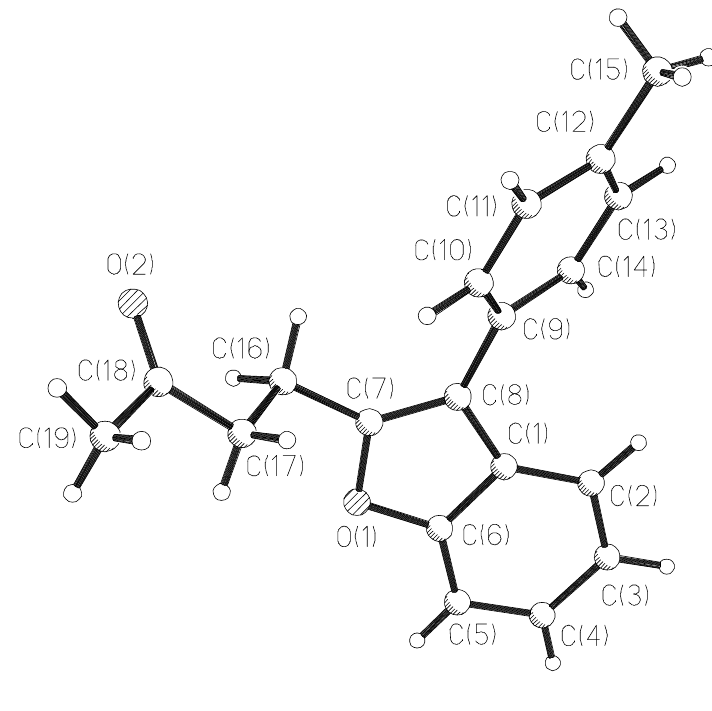
Figure 1. The X-Ray crystal structure of 3e . Table 5. Crystal data and structure refinement of 3e